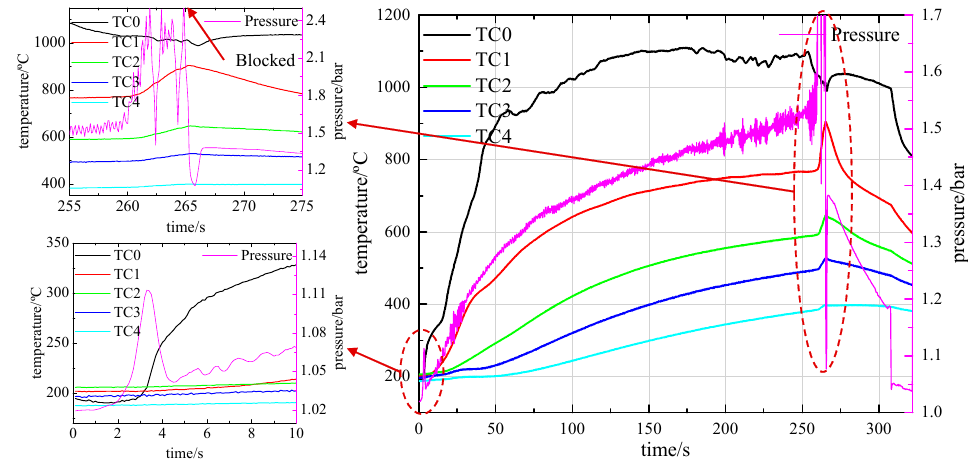
Figure 7. Temperature and pressure curve of a model thruster with the convergent nozzle at a 2 mL/min flow rate.